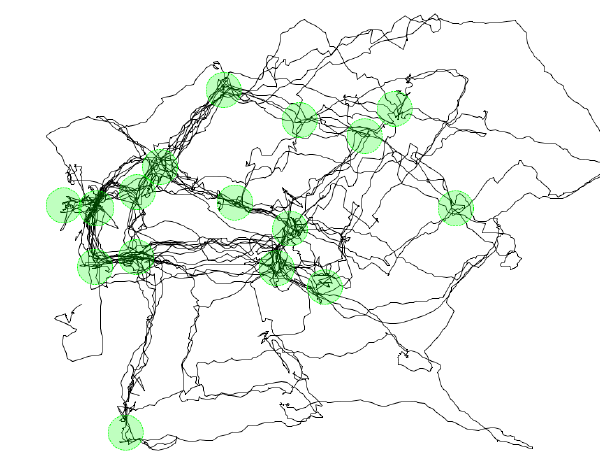
Figure 7: The extracted interesting places of the GPS game dataset...